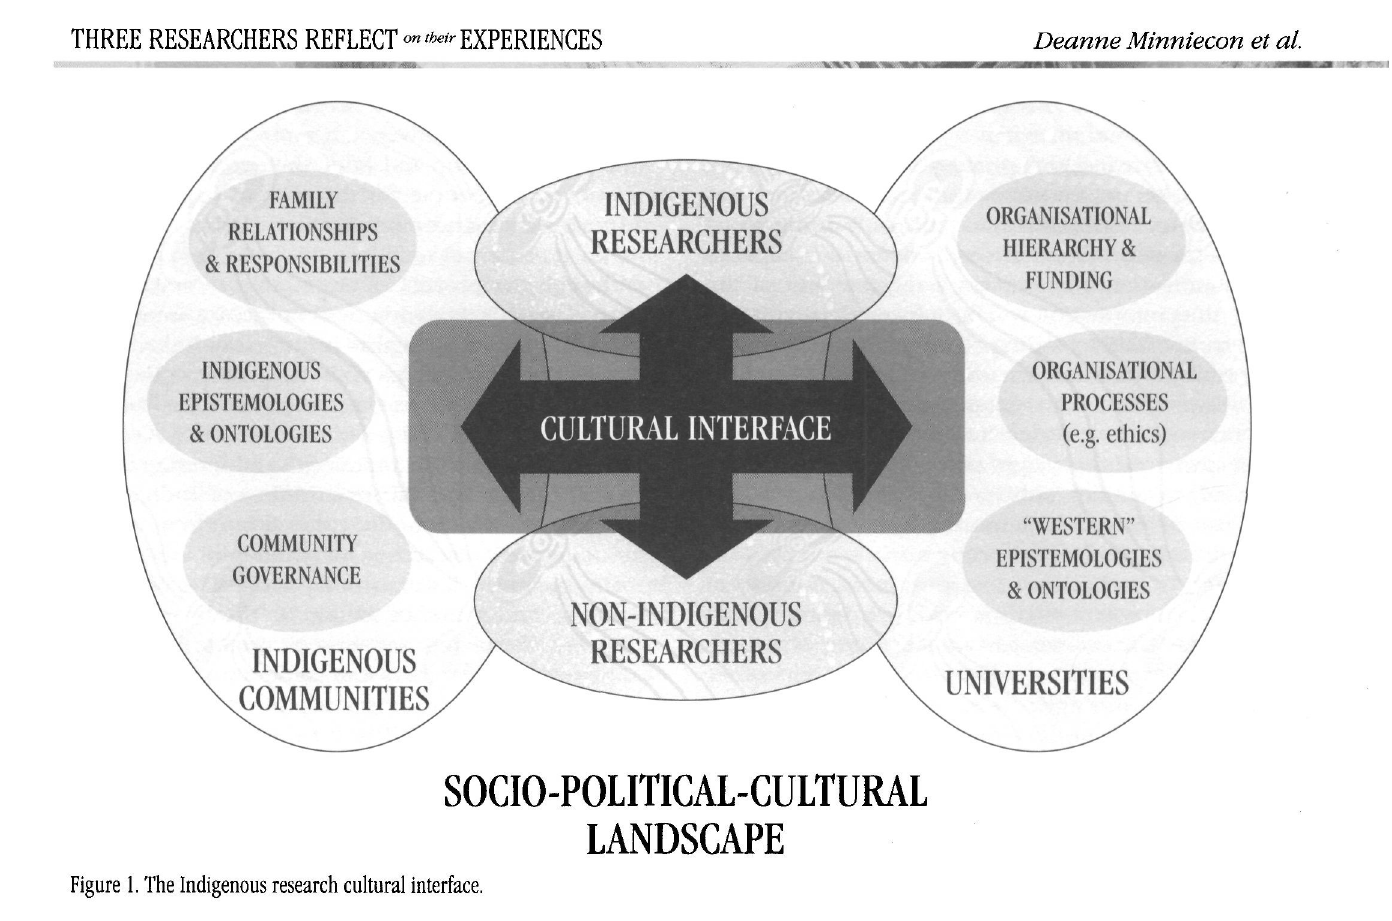
Figure 1. The Indigenous research cultural